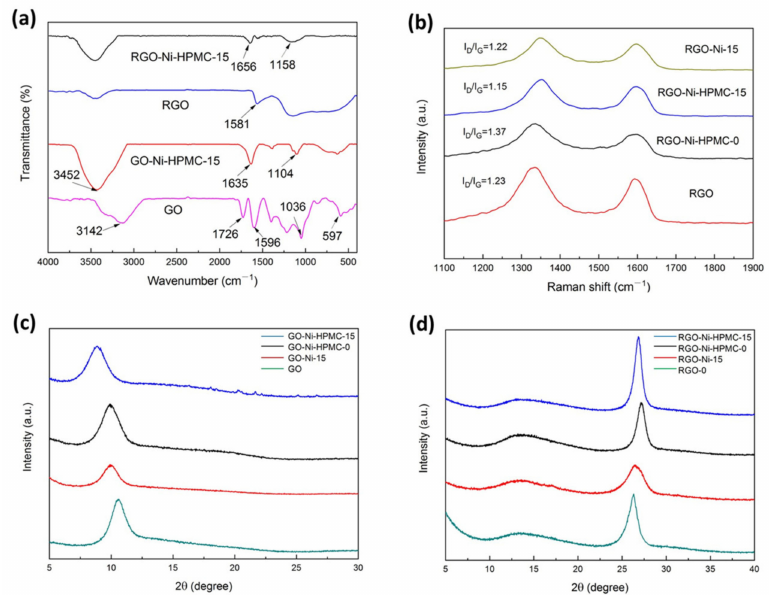
Figure 3. ( a ) Shows the infrared spectra of GO and GO-Ni-HPMC-15 films before and after ther- mal reduction treatment; ( b ) Raman spectra of RGO-Ni-HPMC-15, RGO-Ni-HPMC-0, RGO and RGO-Ni-15 films; ( c ) XRD images of GO-Ni-HPMC-15, GO-Ni-HPMC-0, GO and GO-Ni-15 film; ( d ) XRD analysis of RGO-Ni-HPMC-15, RGO-Ni-HPMC-0, RGO and RGO-Ni-15